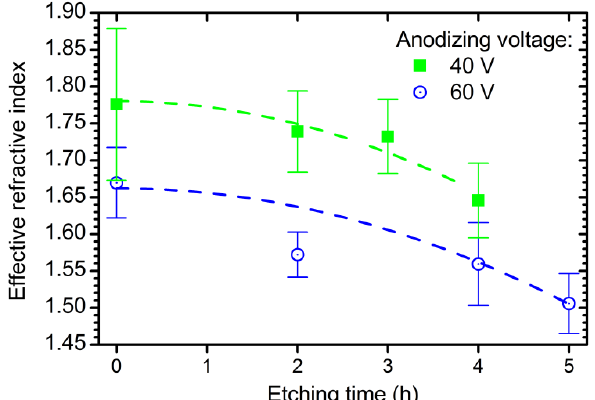
Figure 2. Dependences of the effective refractive index of the anodic titanium oxide at a wavelength of 800 nm on additional etching time in electrolyte solution. Experimental data for the samples obtained at 40 V (green squares) and 60 V (blue circles) are shown. Dashed lines represent the fitting of experimental data by empirical function (Equation